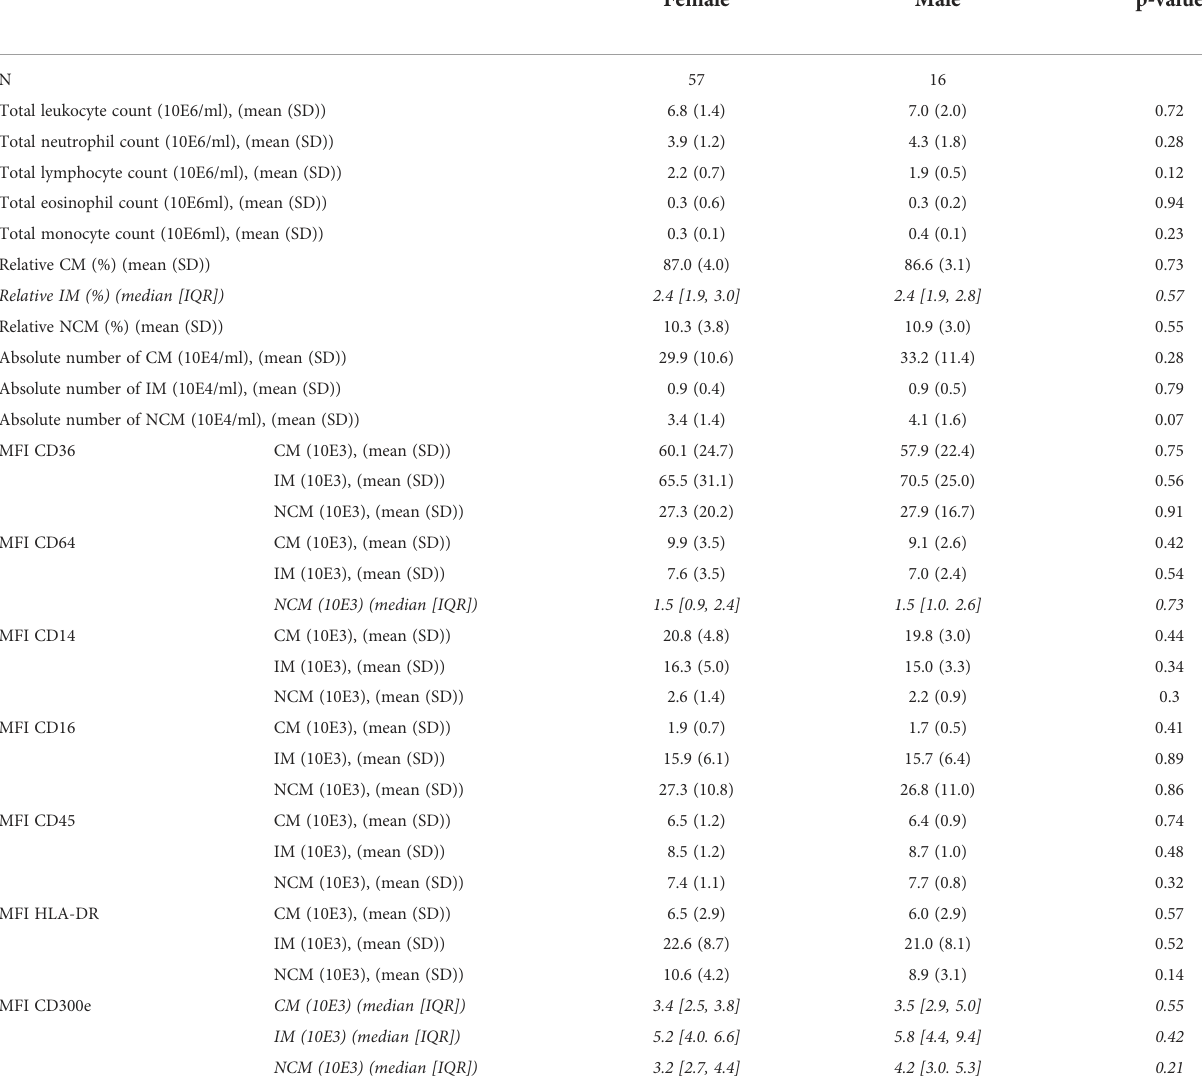
TABLE 2 Leukocyte subset counts and monocyte subset phenotypes at baseline of individuals with obesity. Female Male p-value